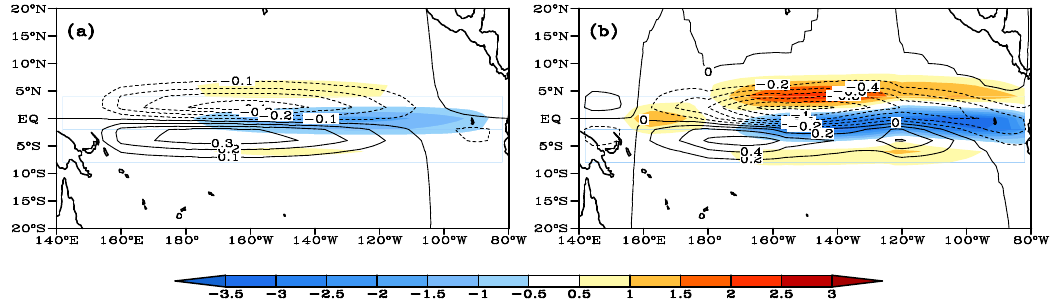
Figure 11. The divergence field (shade) and the meridional wind velocity (contour line) of the Rossby wave responses ( a is CP-El Niño, and b is EP-El Niño). The continents are shown just for geographical reference.